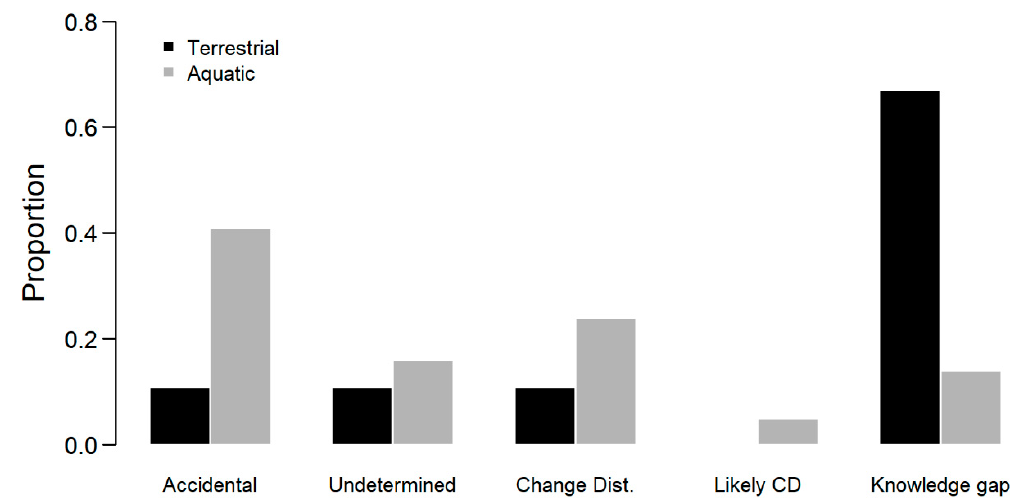
Figure 3. Proportion of species linked to aquatic or terrestrial ecosystems of the 46 new records of bird species recorded for the Ecuadorian part of the Tumbesian region in the last two decades. They are classified according to five categories (Accidental, Undetermined, Change of distribution range (Change Dist.), Likely change of distribution range (Likely CD), and Knowledge gap) denoting the nature of these new records.